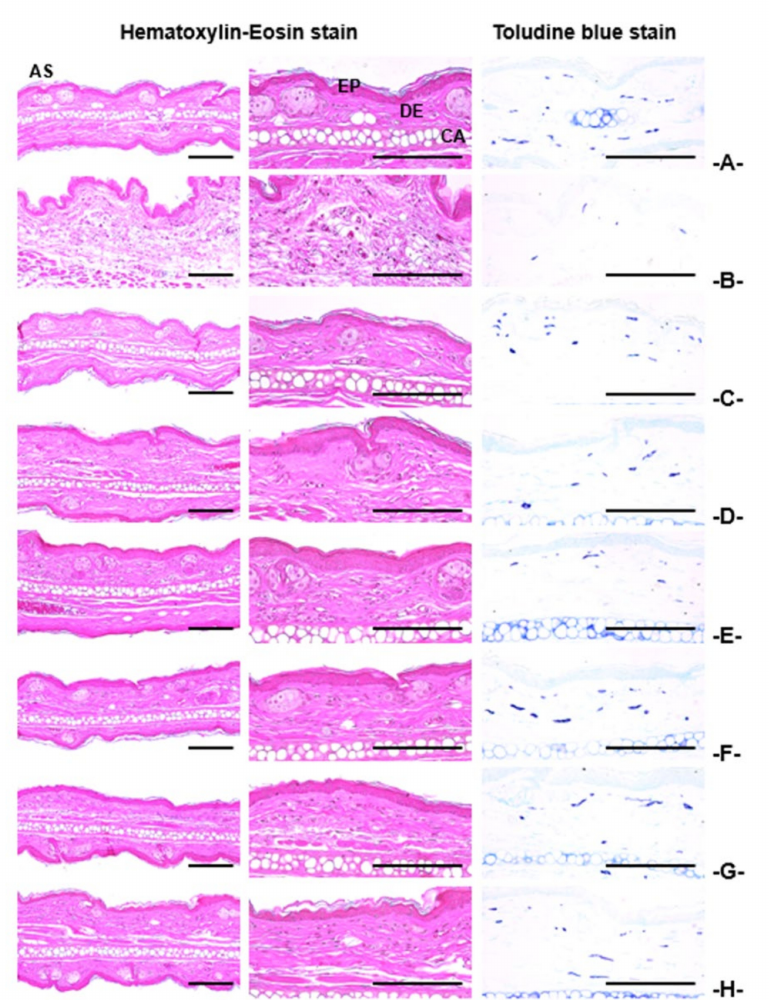
Figure 8. Changes in the histological features of ear in mice. Different treatment groups as followed by the ( A ) intact vehicle control, ( B ) xylene control, ( C ) DEXA 1 mg/kg + xylene, ( D ) AR 400 mg/kg + xylene, ( E ) KOG 400 mg/kg + xylene, ( F ) SKOG 400 mg/kg + xylene, ( G ) SKOG 200 mg/kg + xylene, and ( H ) SKOG 100 mg/kg + xylene. Scale bar = 120 µ m. AS: Anterior Surface; CA: Cartilage; DE: Dermis; EP: